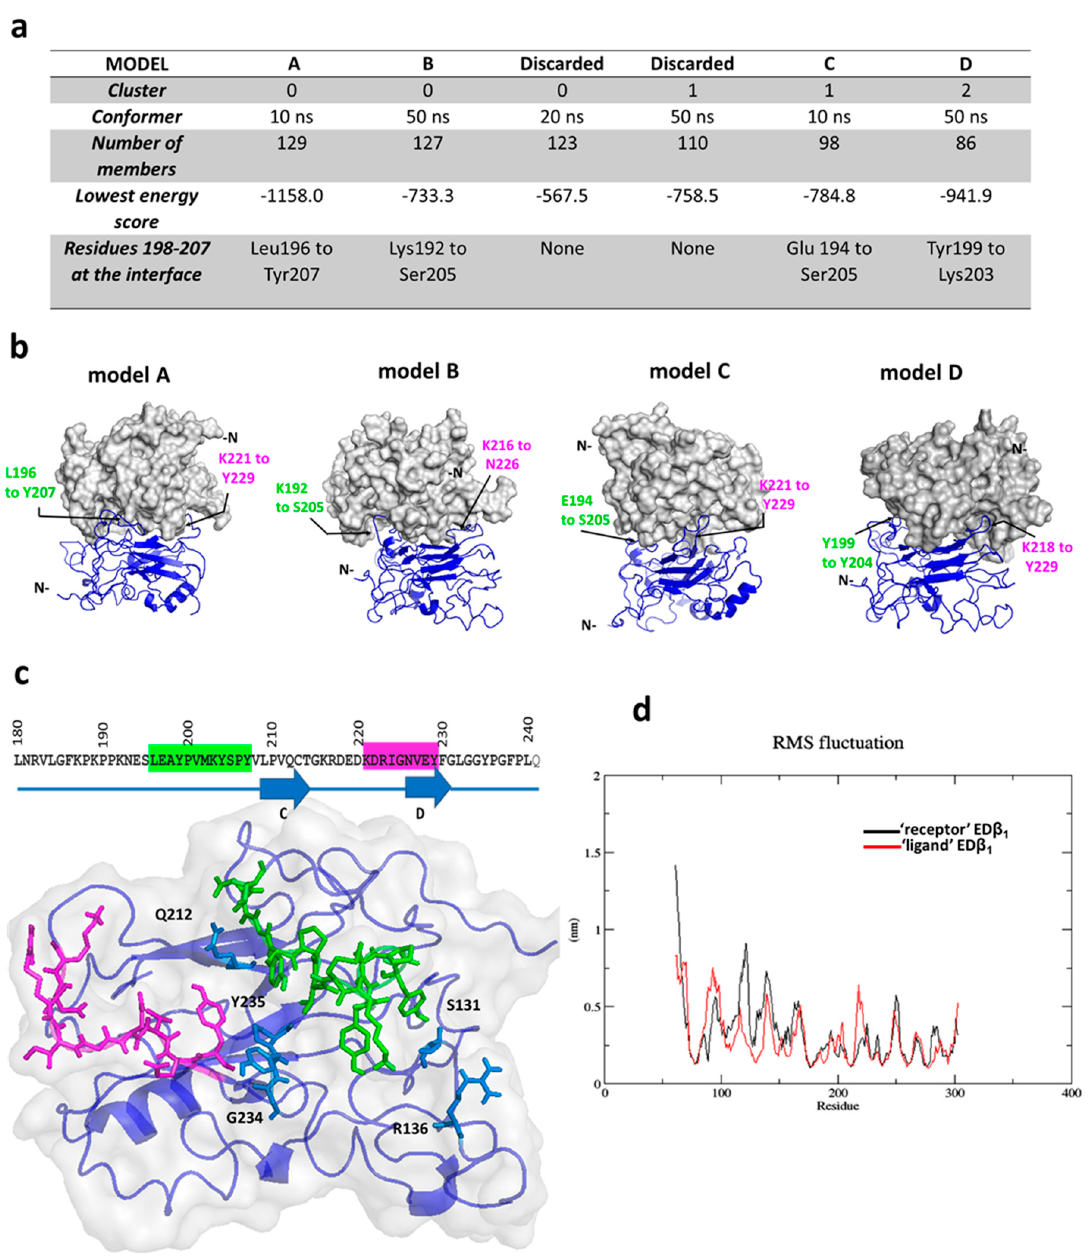
Figure 3. Docking of ED β 1 and description of the interface. ( a ) Docking results for the top six largest clusters. ( b ) Models for each of the selected four dimers. One ED β 1 is depicted in surface representation (gray) and the docked ED β 1 in cartoon representation (blue). Black arrows identify amino acid residues within the same segments (magenta for Lys221–Tyr229 and green for Leu196–Tyr207). ( c ) The interface of model A. The two main segments forming the interface are marked in the β 1 subunit sequence keeping the same color code as in ( b ). Interface residues highlighted in sticks representation. Light blue residues are those that appear at the interface but are non-continuous in sequence. ( d ) RMSF of model A during 50 ns of Molecular Dynamics simulations.